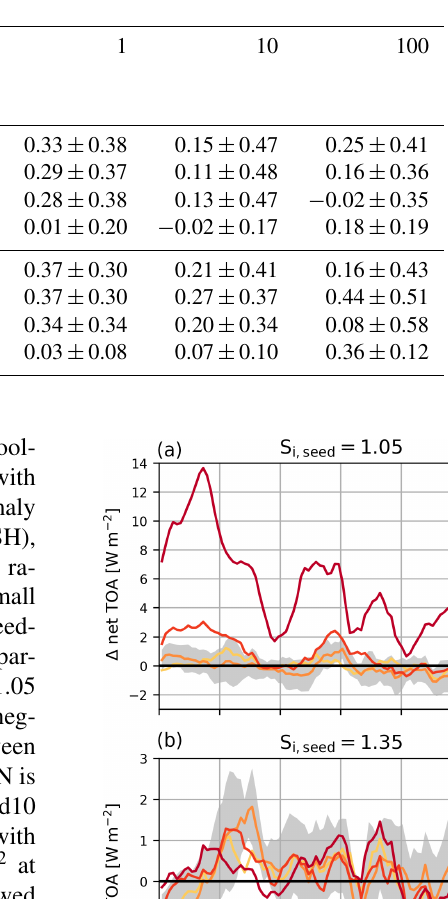
Table 5. Five-year annual global mean net TOA total radiative balance and net CRE as well as SW CRE and LW CRE in Wm − 2 for the D19 and S89 ice cloud fraction approaches for seeding at S i,seed = 1.35. Each quantity includes the 95% confidence interval equating to 2 standard deviations of the mean values of the 5-year data.